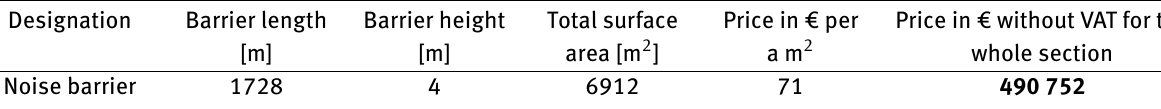
Table 3: Funds for the bypass variant - noise barrier Designation